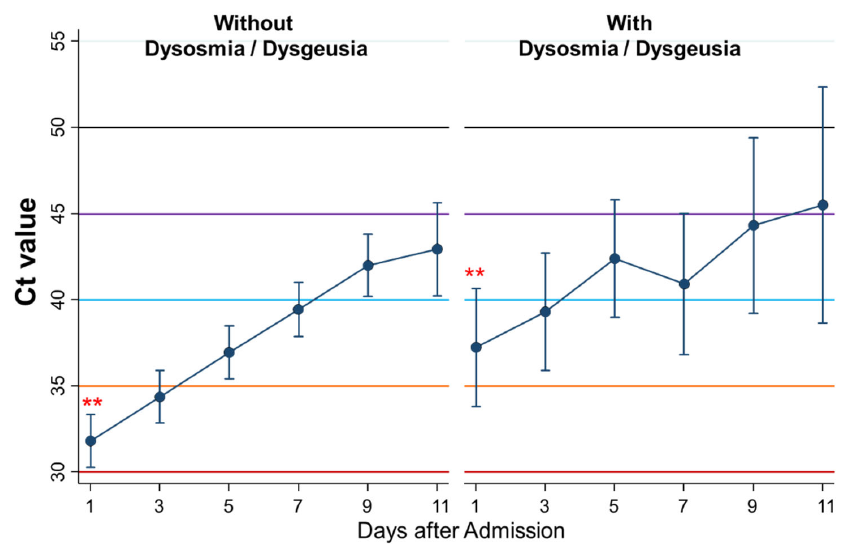
Figure 7. Differential kinetics of Ct values between patients without dysosmia/dysgeusia and with dysosmia/dysgeusia. Mean Ct with 95% confidence intervals. When the Ct value is 40 or more, the PCR test result is considered negative. ** represents a significant difference ( p < 0.005).